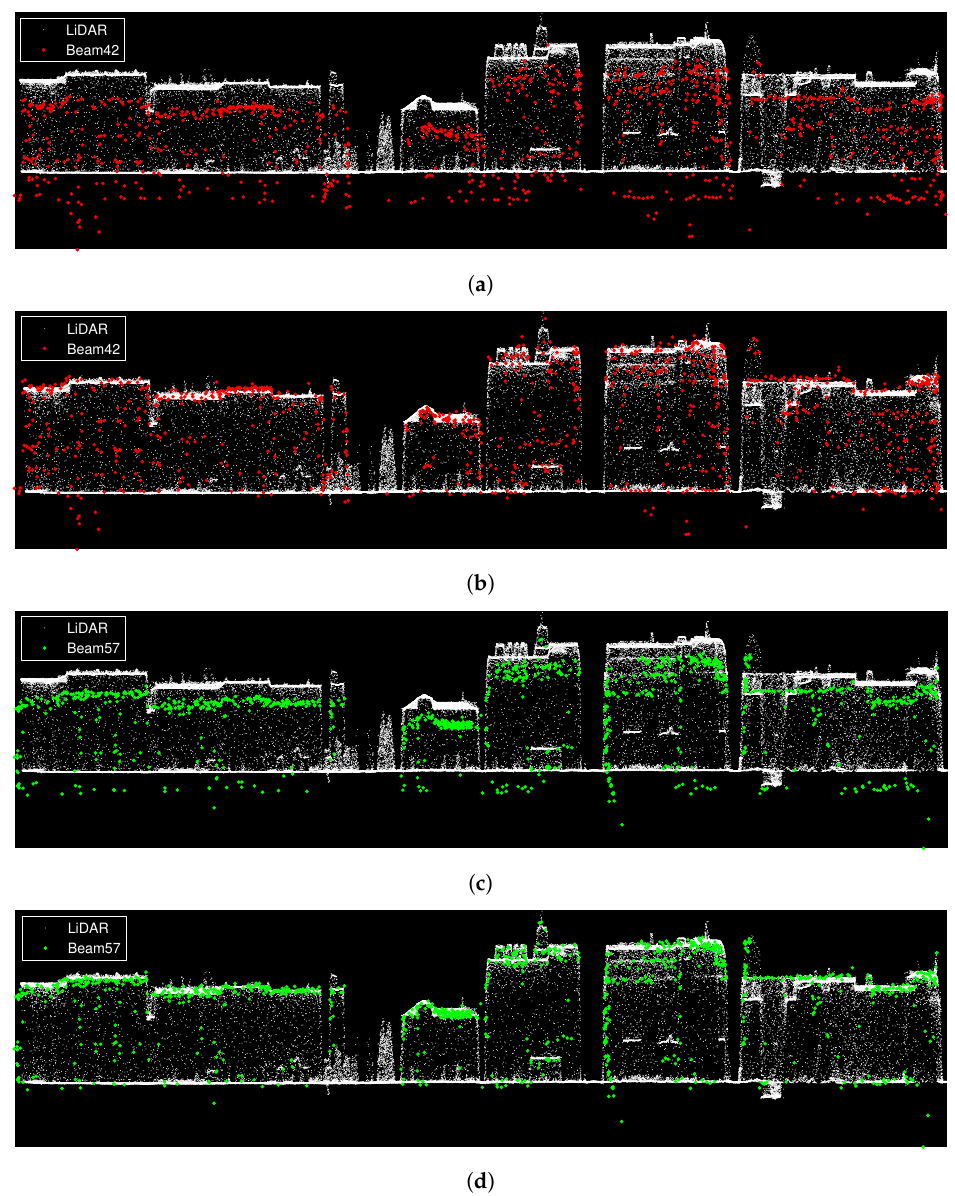
Figure 14. 1D vertical localization accuracy analysis of PSI point clouds, before and after applying geodetic corrections and height offset compensation, in comparison with LiDAR. The x - and y -axes correspond to the Easting in UTM and ellipsoidal height, respectively. Green and red dots show the ascending (Beam57) and descending (Beam42) point clouds while white dots show the LiDAR data. ( a , c ) depict the non-corrected point clouds while ( b , d ) correspond to the corrected ones. The height shifts, caused by the unknown DEM error of the reference points are easily recognizable in non-corrected point clouds while the offsets are compensated for in the corrected results. Note that the Easting and the height are differently scaled in order to emphasize the vertical